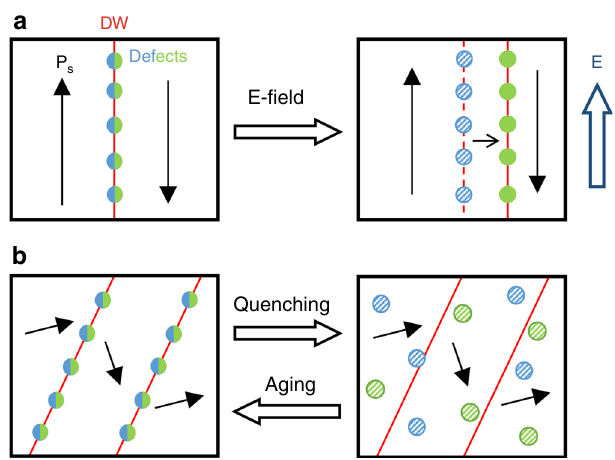
Fig. 4 Effect of electric fi eld and thermal treatment on defect state. Simpli fi ed schematic representation of the effect of a electric- fi eld (E) and b quenching and aging on the defect location. The red lines, black arrows and colored circles indicate the domain walls (DWs), spontaneous polarization (P S ) and point defects, respectively. The blue and green circles represent Bi vacancies and electron holes (Fe 4 + states), respectively (same colour coding is used for the half-coloured circles). For simplicity, the oxygen vacancies are not considered. Locations of defects represented by full circles were experimentally con fi rmed by STEM, while locations of the defects represented by patterned circles are assumed based on ion-mobility (panel a , right box) and quenching concepts (panel b , right box). The dashed red line in the right box of panel a represent the initial DW position before fi eld application; here, the patterned circles, representing Bi vacancies, were drawn on this line for illustrative purposes, however, short- range Bi-vacancy migration cannot be completely excluded. The scheme shown in panel a corresponds to the DW pinning model developed by Postnikov et al. 55 ; see main text for further details. The choice of the domain-wall type (180° and non-180°) is arbitrary. Note that in the real scenario due to the thermal excursion above T c , the domain structure after quenching is most likely not the same; in panel b the same DWs in the left and right boxes are thus drawn for simplicity and for only purpose to represent the order and disordered defect state in aged and quenched samples, respectively. Due to the high quenching temperature (900 °C), the defects in the quenched state are assumed